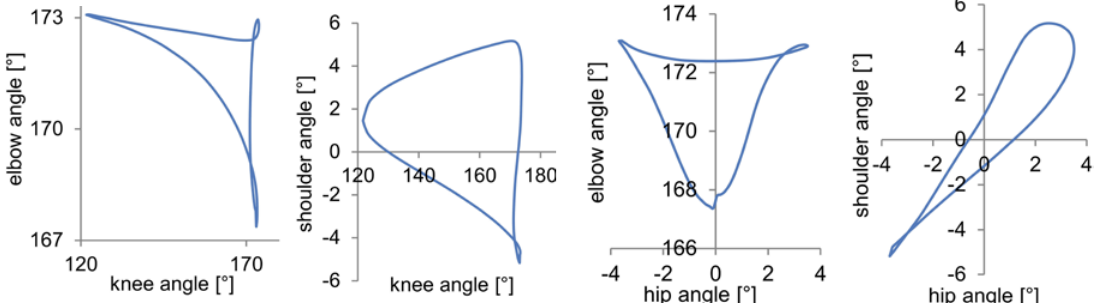
Figure 4. The hip-elbow and hip-shoulder cyclogram of the aver- age joint